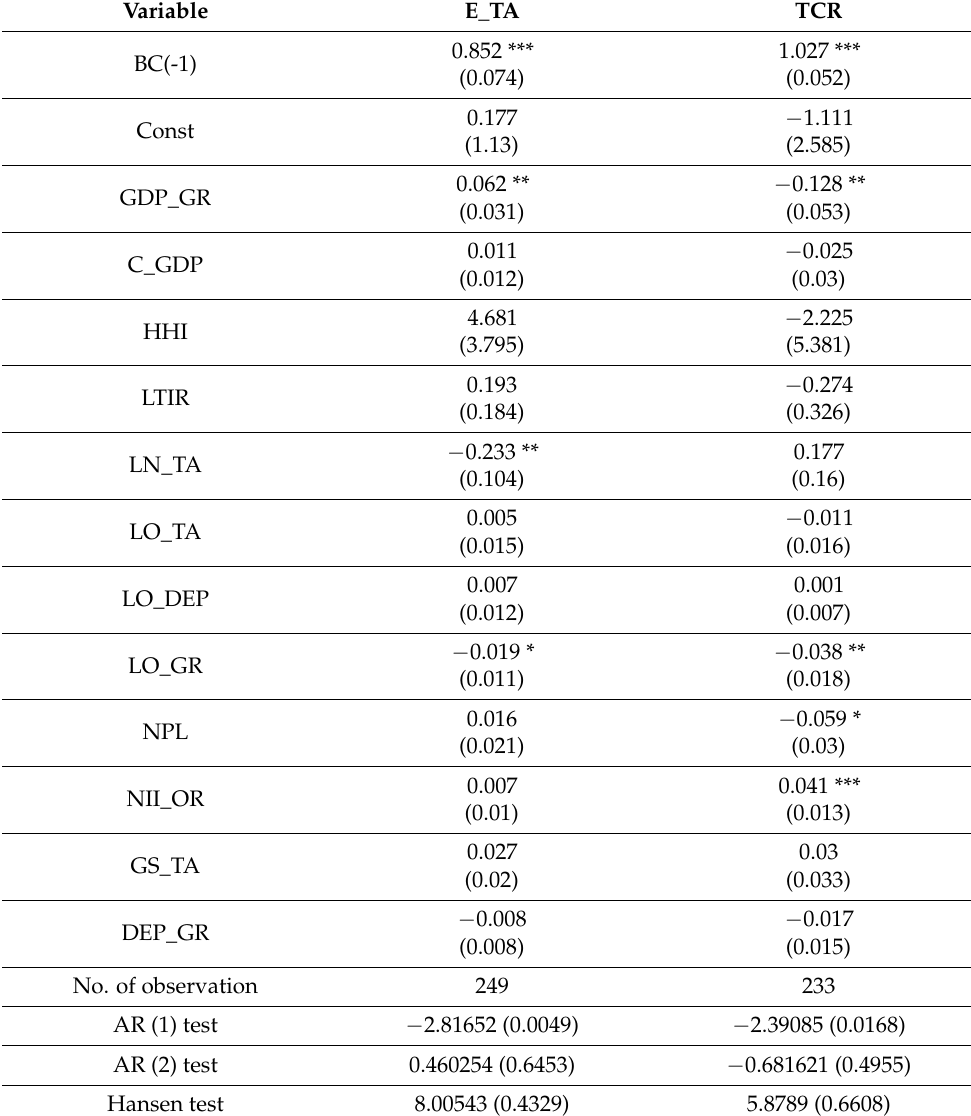
Table 8. Panel model results: indicators of bank capitalization: leverage (E_TA) and